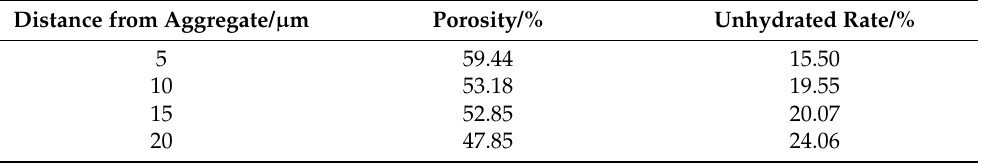
Table 9. BSE quantitative calculation of